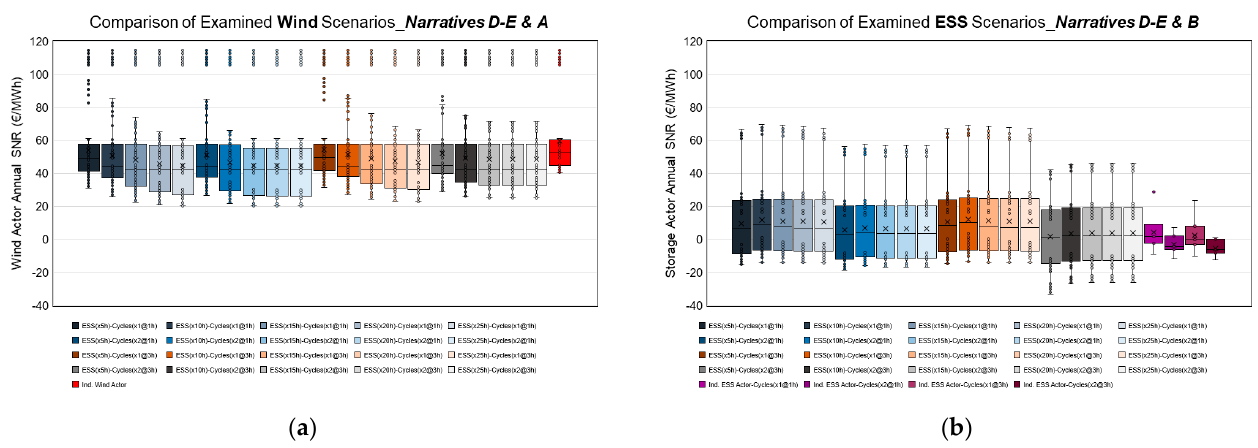
( b ) Figure 13. Wind-supported ESS market participation for independent actors and an individual wind-storage actor; annual NR of the storage component for SCF = 50% ( a ) and SCF = 0% ( b ) per di ff erent storage con fi guration and cycling option. 4. Discussion Following the presentation of simulation results per di ff erent narrative examined,